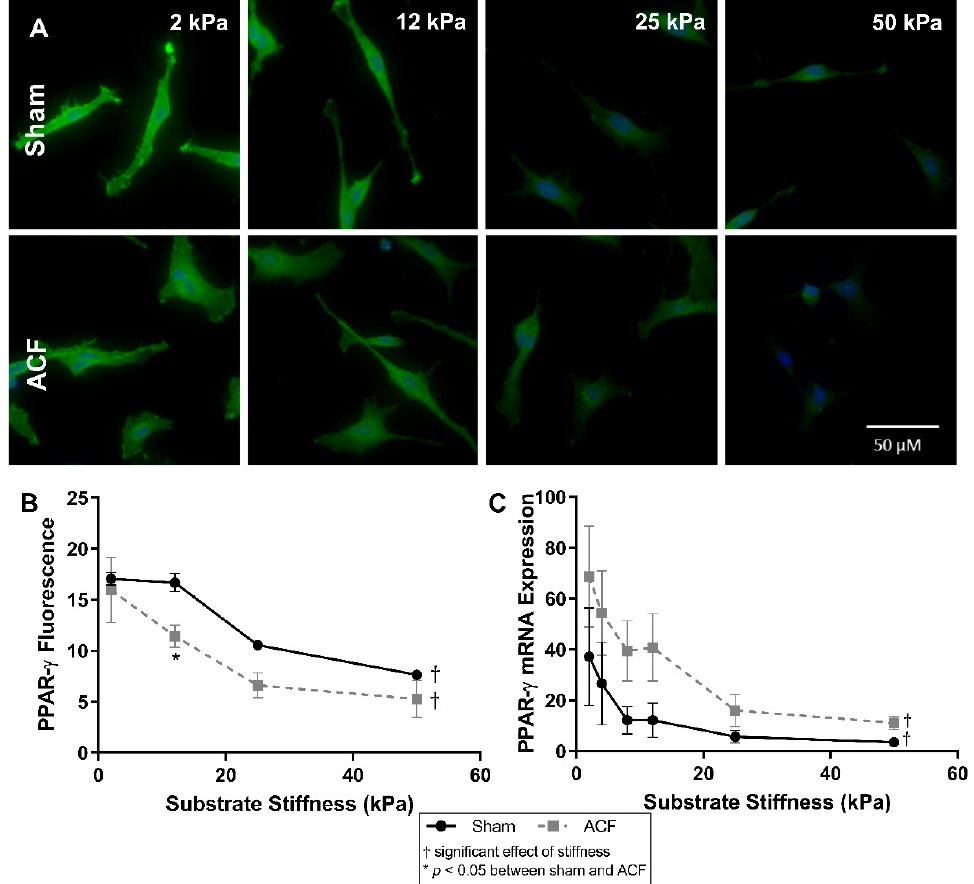
Figure 7. ( A ) PPAR- γ fluorescence (green) with DAPI nuclear counterstain (blue) and quantification ( B ) show a decrease in intensity with increasing stiffness. ( C ) mRNA expression is also inversely related with substrate stiffness. The highest expression and fluorescence and mRNA levels appears on the softest substrates. * indicates p < 0.05 when comparing sham vs. ACF. † indicates a signi fi cant e ff ect of substrate sti ff ness.